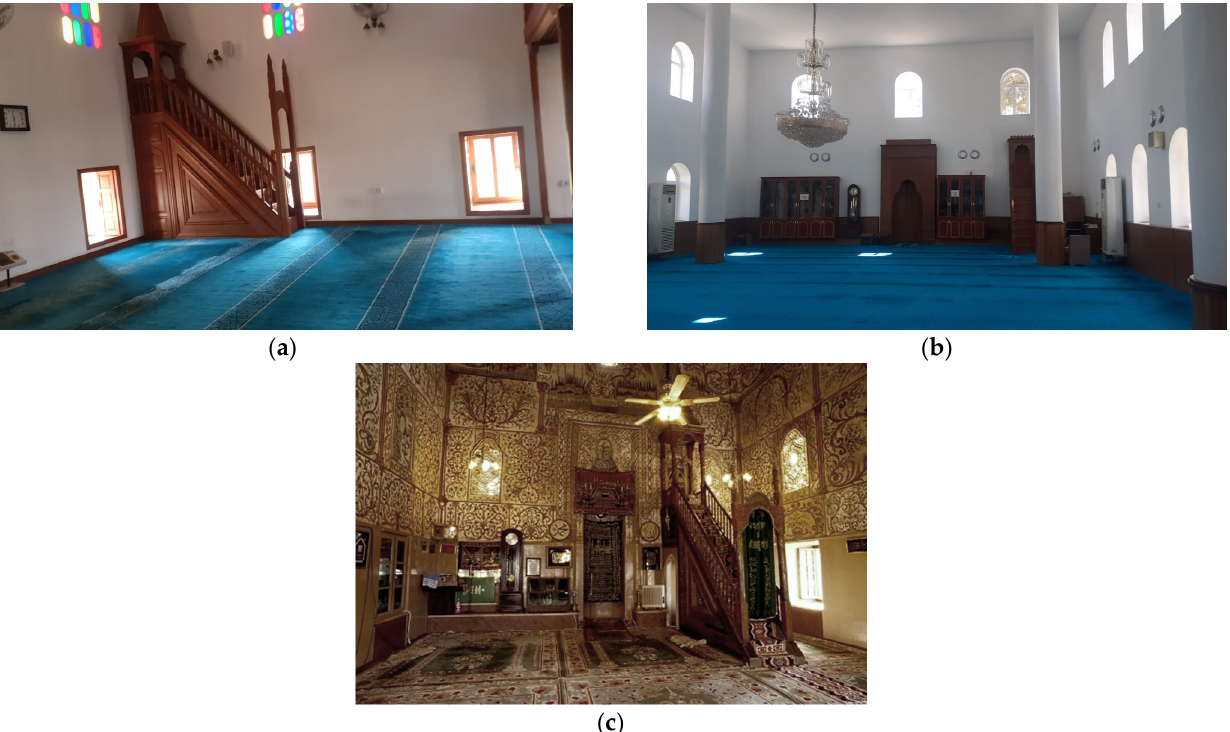
Figure 13. Example of interior design inside the selected mosques: internal views of ( a ) Naziresha Mosque of Elbasan, ( b ) Kubalie Mosque of Kavaja, ( c ) Et’hem Bey Mosque of Tirana.